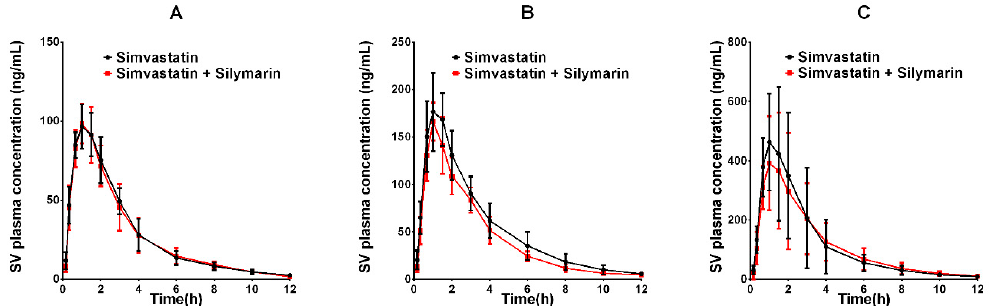
Figure 3. The pharmacokinetic profiles of SVA in rats after oral administration of different doses of SV with or without treatment with silymarin (45 mg/kg). ( A ) Dose of SV at 20 mg/kg; ( B ) dose of SV at 40 mg/kg; ( C ) dose of SV at 80 mg/kg.